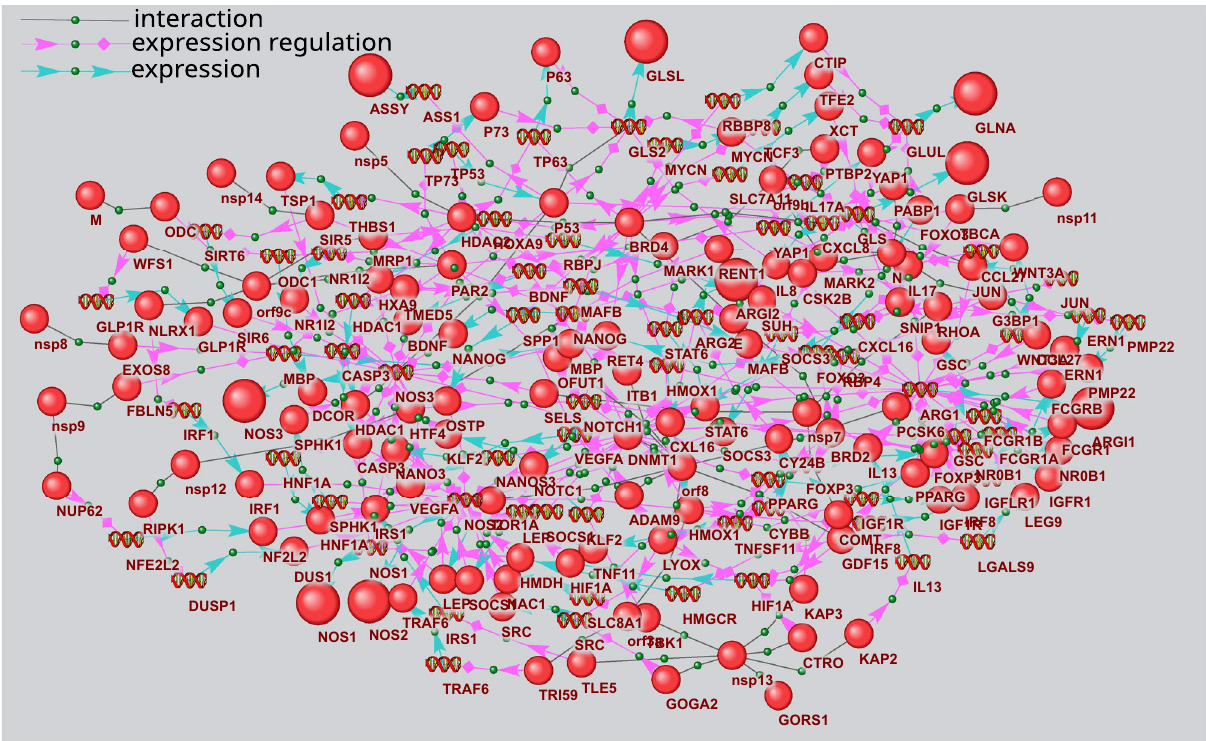
Figure 6. Gene network describing P 4 and P 5 pathways of arginine biosynthesis gene expression regulation. The bigger balls show the arginine biosynthesis proteins, while the smaller ones designate other proteins. Spirals designate the genes.